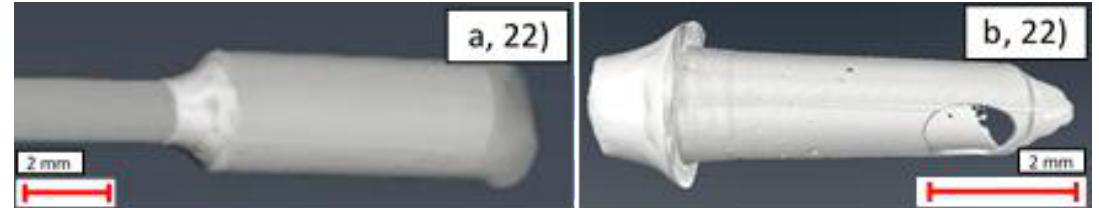
Figure 23. CT images of Ni + Cu-coated sample (22): ( a ) side view of pipe and gland exterior; ( b ) side view of right side interior solder.